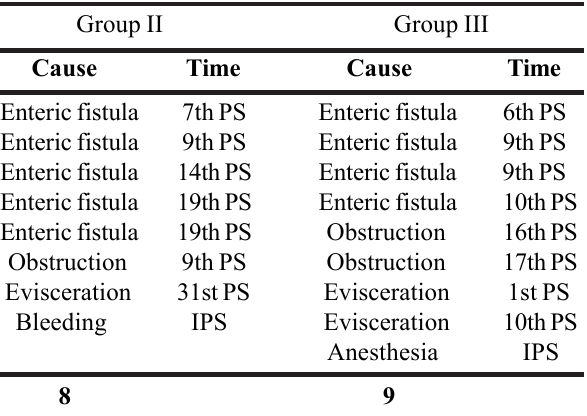
TABLE 1 - The causes of deaths in group I and group